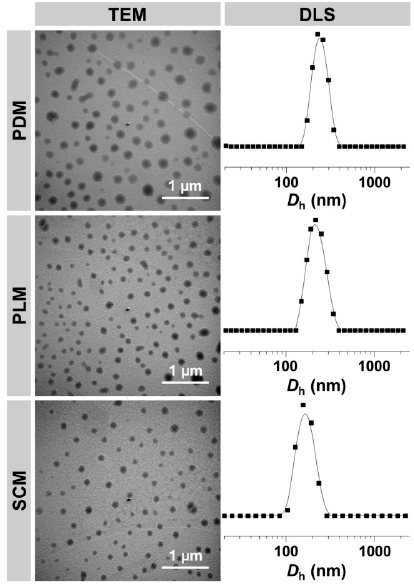
Figure 2. Typical TEM micrographs and D h s of PDM, PLM, and SCM.